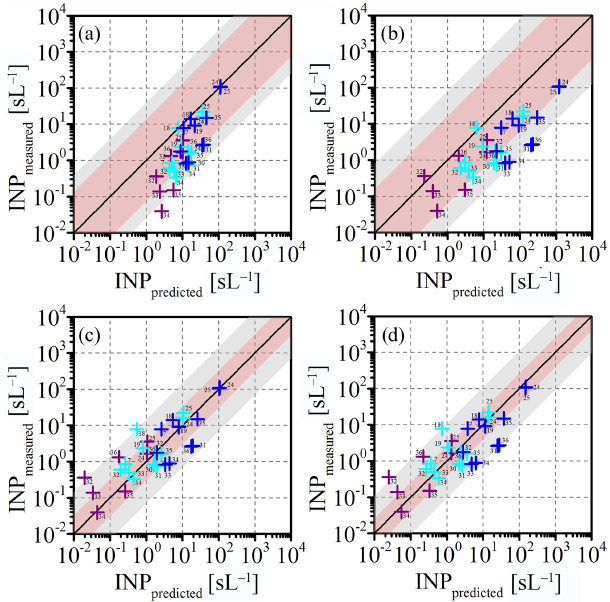
Figure 12. Scatterplot of INP concentration measured by FRIDGE against the same as predicted by (a) D10 and (b) D15. Panel (c) uses the same parameterization as (b) with the exception that cf is set to the best fit of 0.086. Panel (d) also has the same fixed values for α , β , δ , and cf as in (c) , but the constant γ is fitted to best rep- resent the measured data. The confidence intervals of 1 σ (70%) and 2 σ (97%) are indicated by a red and gray belt around the 1 : 1 line. FRIDGE data were measured at RH water = 101% and tem- peratures − 20 ◦ C (purple), − 25 ◦ C (cyan), and − 30 ◦ C (blue) and had valid OPC measurements carried out simultaneously aboard Cruiser. Numbers beside the symbols corresponds to the sample numbers from Fig.